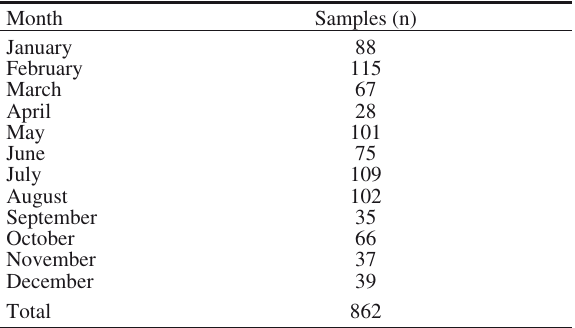
Table 1. – Number of dolphinfish, Coryphaena hippurus , sampled by month between 2007 and 2011.